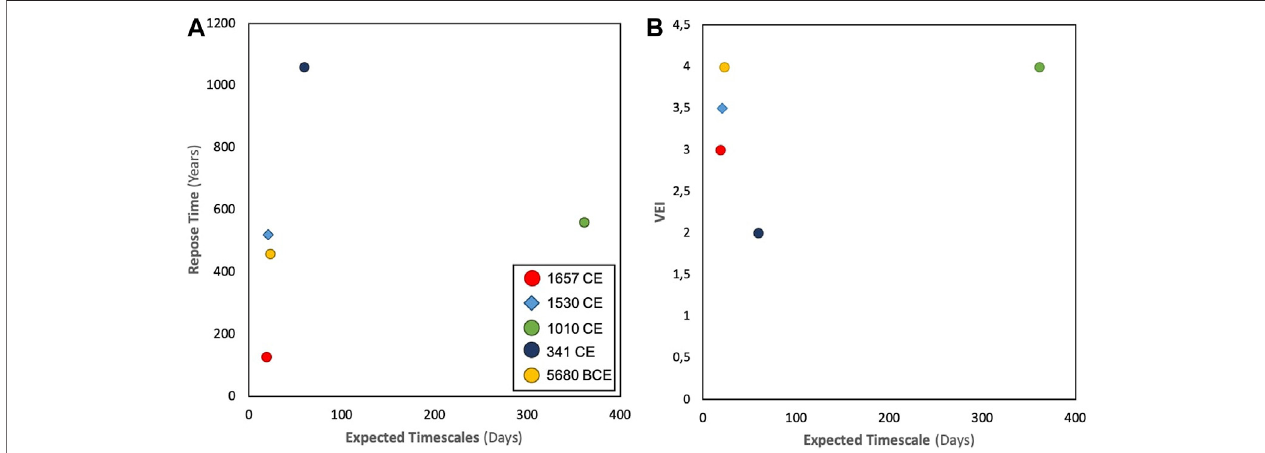
FIGURE 11 | Schematic sketches of the mush lenses beneath La Soufriére de Guadeloupe and Echelle with representative crystals shown at approximate locationswithinthemushzone. (A) TheLaSoufriéredeGuadeloupemushsystempriortoeruption,thisstudysuggests intrusionsbeginabetweenaminimumof84and 3,052dayspriortoeruption. (B) Inthecaseof1657Cal.CEand5680Cal.BCEeruptions,theexpectedvalueshowsthatthemajorityofthesystemcouldbeaffectedby an intrusion 19 and 23 days prior to eruption, respectively. The intrusion moves through the system rapidly, in the case of the 5680 Cal. BCE eruption crystals are erupted from deep in the mush system which re-equilibrate during smaller intrusion events which do not destabilise the mush system. The 1657 Cal. CE eruption only samplessimplecrystalsand unzoned crystals. (C) The ∼ 341CE eruptionexpectedvalueshows thatthemajorityofthesystemcould beaffected byanintrusion 59days before eruption. This intrusion has also moved relatively rapidly through the system and variation in intrusion location, results in destabilisation and eruption from the Echelle vent. Both complex and simple crystal populations are erupted. (D) Processes resulting in the 1010 Cal. CE eruption occurred slower than the other eruptions with the expected value showing the majority of the system could be affected by an intrusion 361 days prior to eruption. The very long delay time suggests that magma may have stalled in the mid-upper mush system, crystals with the diffuse zoning have spent the longest time in contact with the intrusion. (E) System destabilisation results in eruption of populations of simply zoned and unzoned crystals, perhaps from the upper